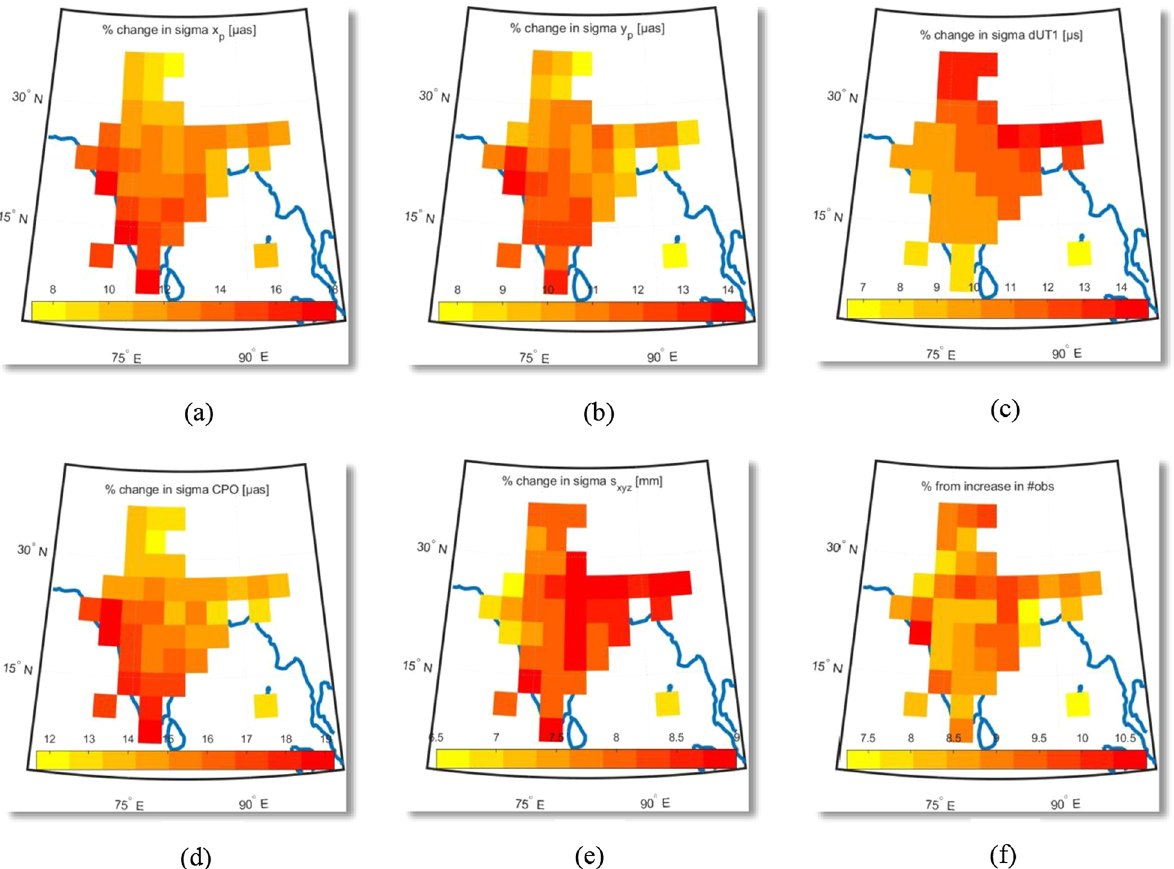
Fig. 7 a – e Percentage improvement in the mean formal error (sigma) of geodetic parameters in the third scenario; f expected improvement percentage from the increase in